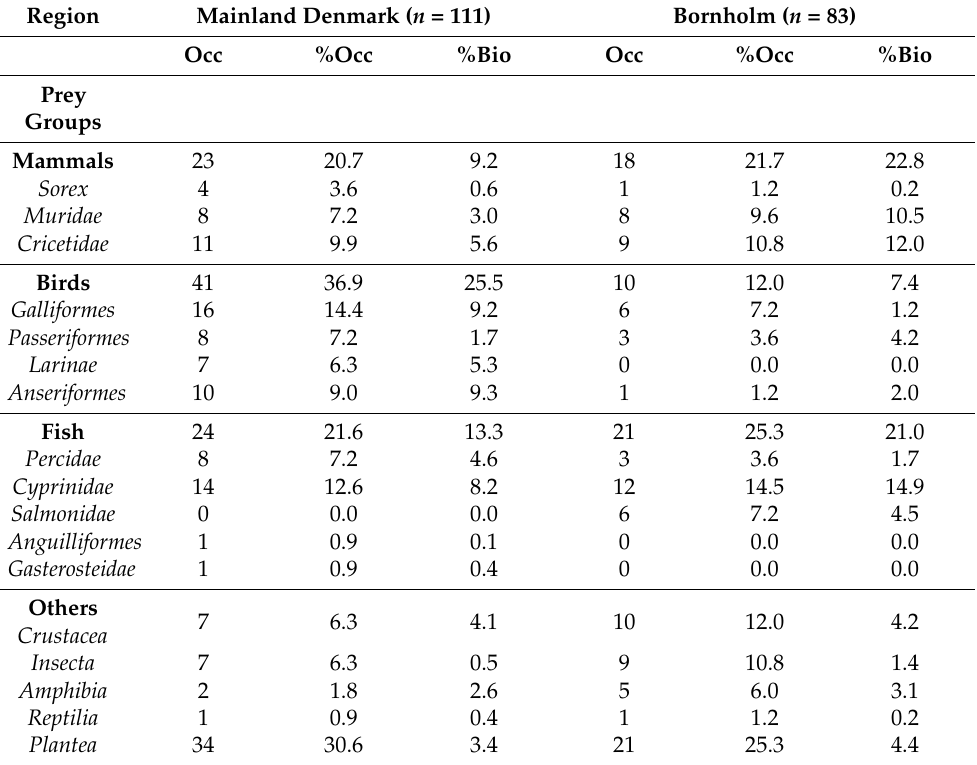
Table 3. Occurrence (Occ), percentages of occurrence (%Occ), and percentage of biomass (%Bio) for mink in mainland Denmark ( n = 111) and mink on Bornholm ( n =